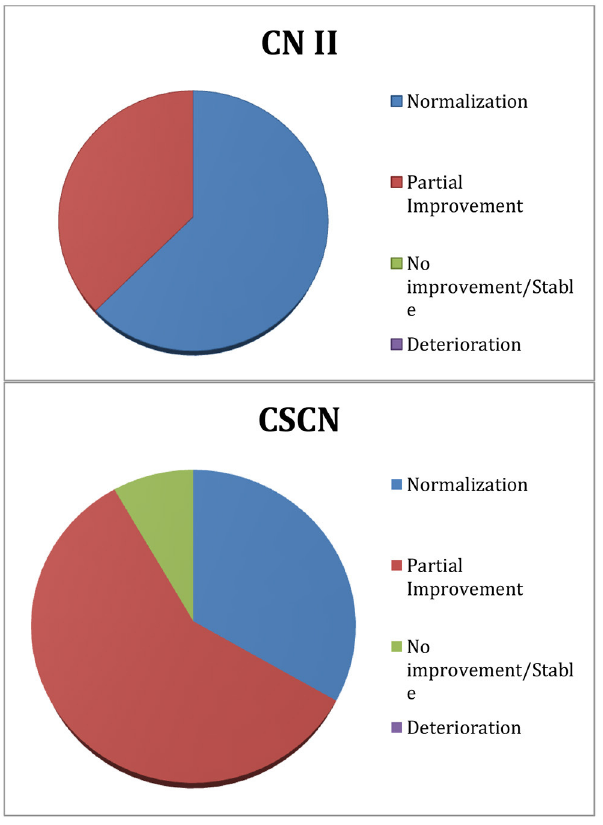
TABLE 2 | Comparison between preoperative and postoperative cavernous sinus cranial nerves (CSCN) outcomes based on the ocular motility grading system. Postoperative